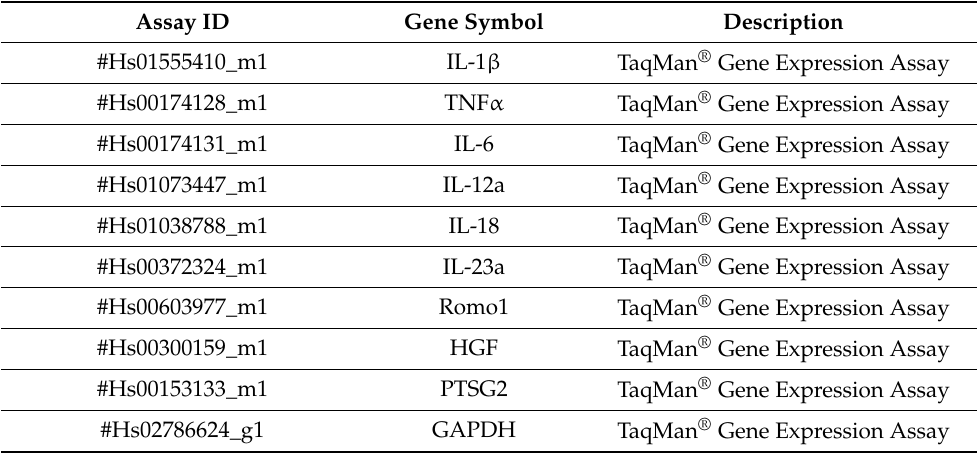
Table 1. List of TaqMan gene expression assays used for the